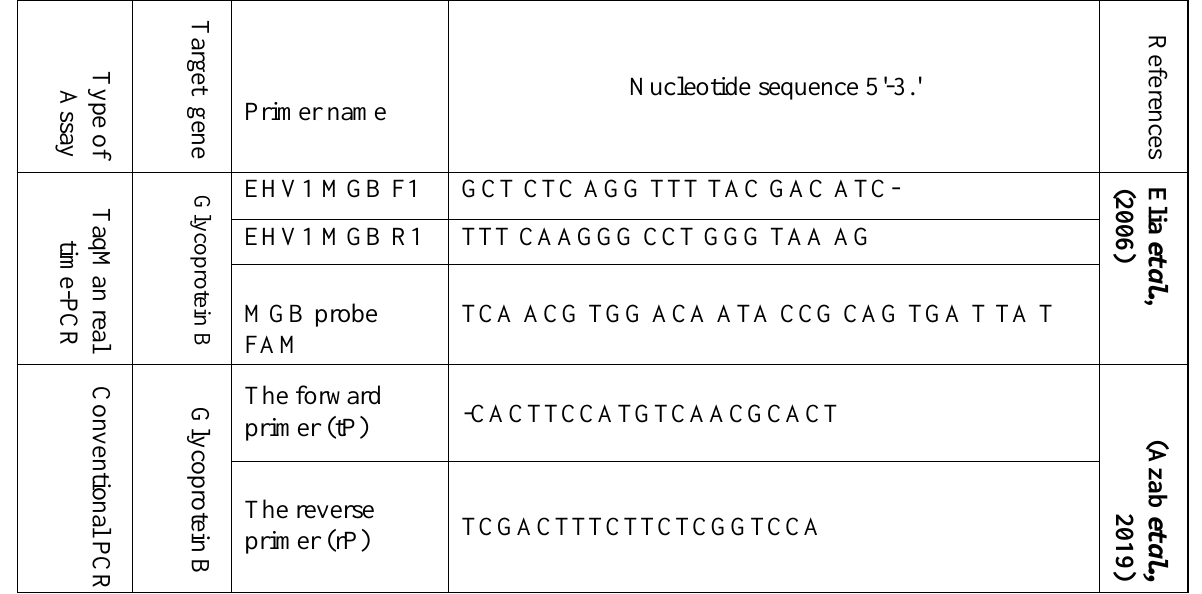
Table 1: List of primers and probes used in molecular detection and amplification of the EHV-1 gB gene in the present study: